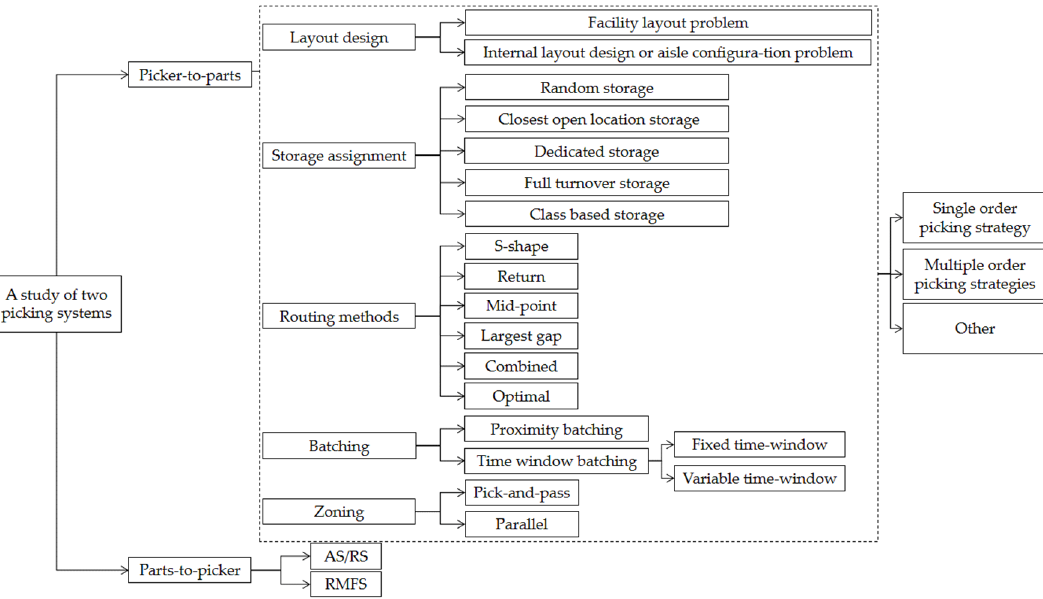
Figure 4. Function diagram of order-picking strategy (Taking the “picker-to-parts” picking system as an example [18]).